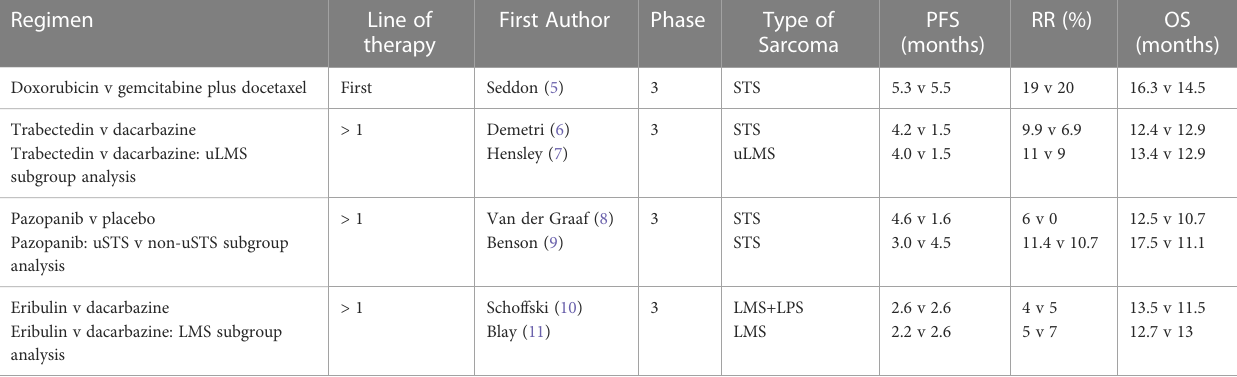
TABLE 1 Selected available systemic therapies for advanced leiomyosarcoma.